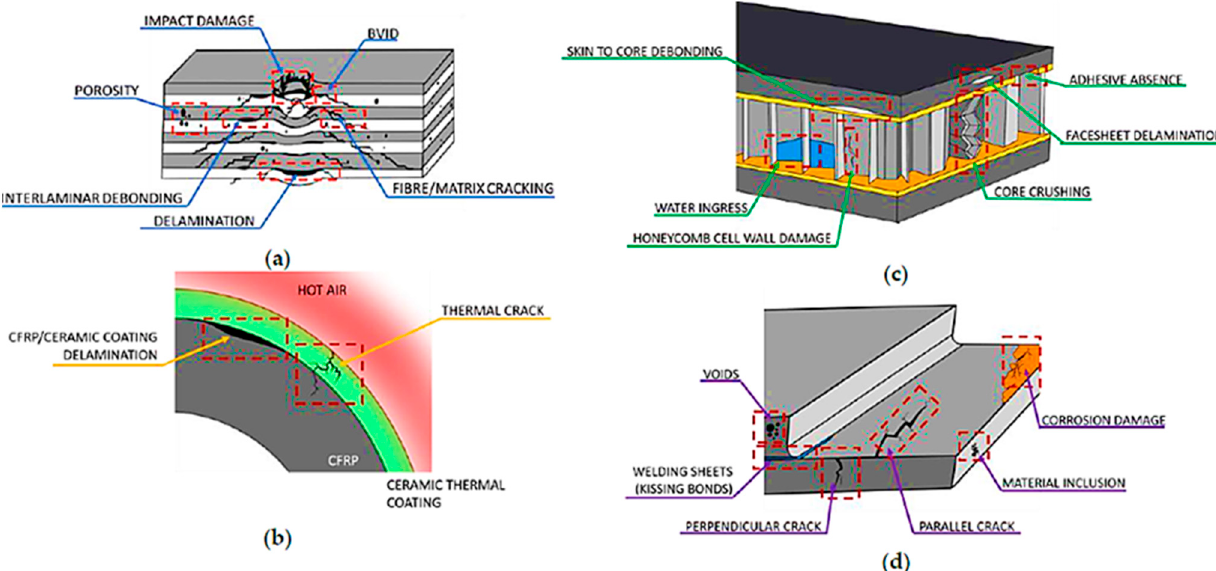
Figure 16. Illustration of typical material defects monitored by IRT for composite aircraft and spacecraft structures ( a ); jet engine turbine blades ( b ); honeycomb panels ( c ) and metallic aircraft and spacecraft components ( d ). Reprinted with permission from [162]. 2018, MDPI.